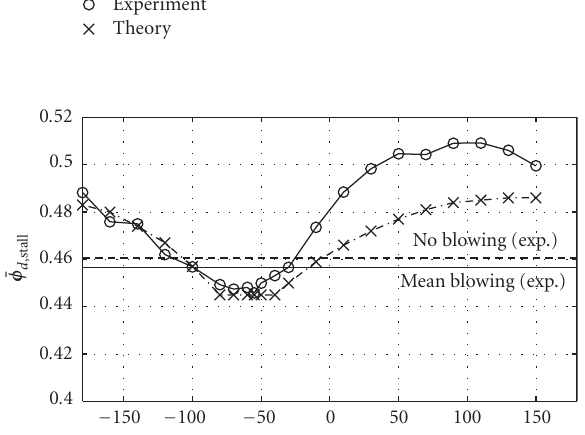
maximum damping of the critical pole at gain values between − 0 . 002 and − 0 . 003, while the experimental critical